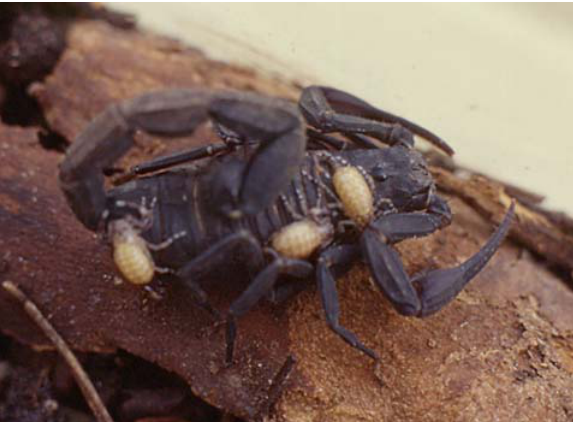
Figure 8. Birth behavior in parthenogenetic female of Tityus metuendus .